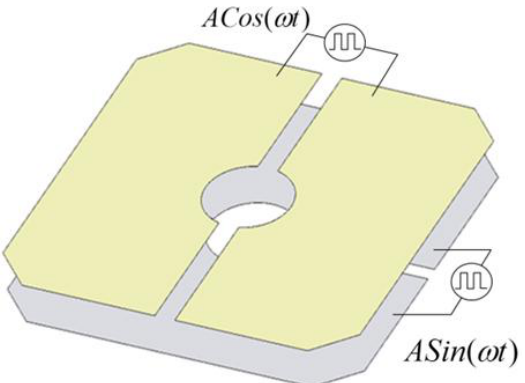
Figure 14. Generating identical orthogonal modes by driving surface electrodes [51].